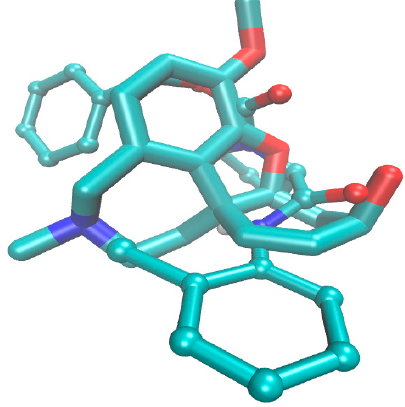
Figure 8. Models of galanthamine (displayed as sticks) and molecule 5a (depicted as ball-and-sticks) in rhAChE catalytic core with nitrogen atom (blue) and oxygen (red), respectively.